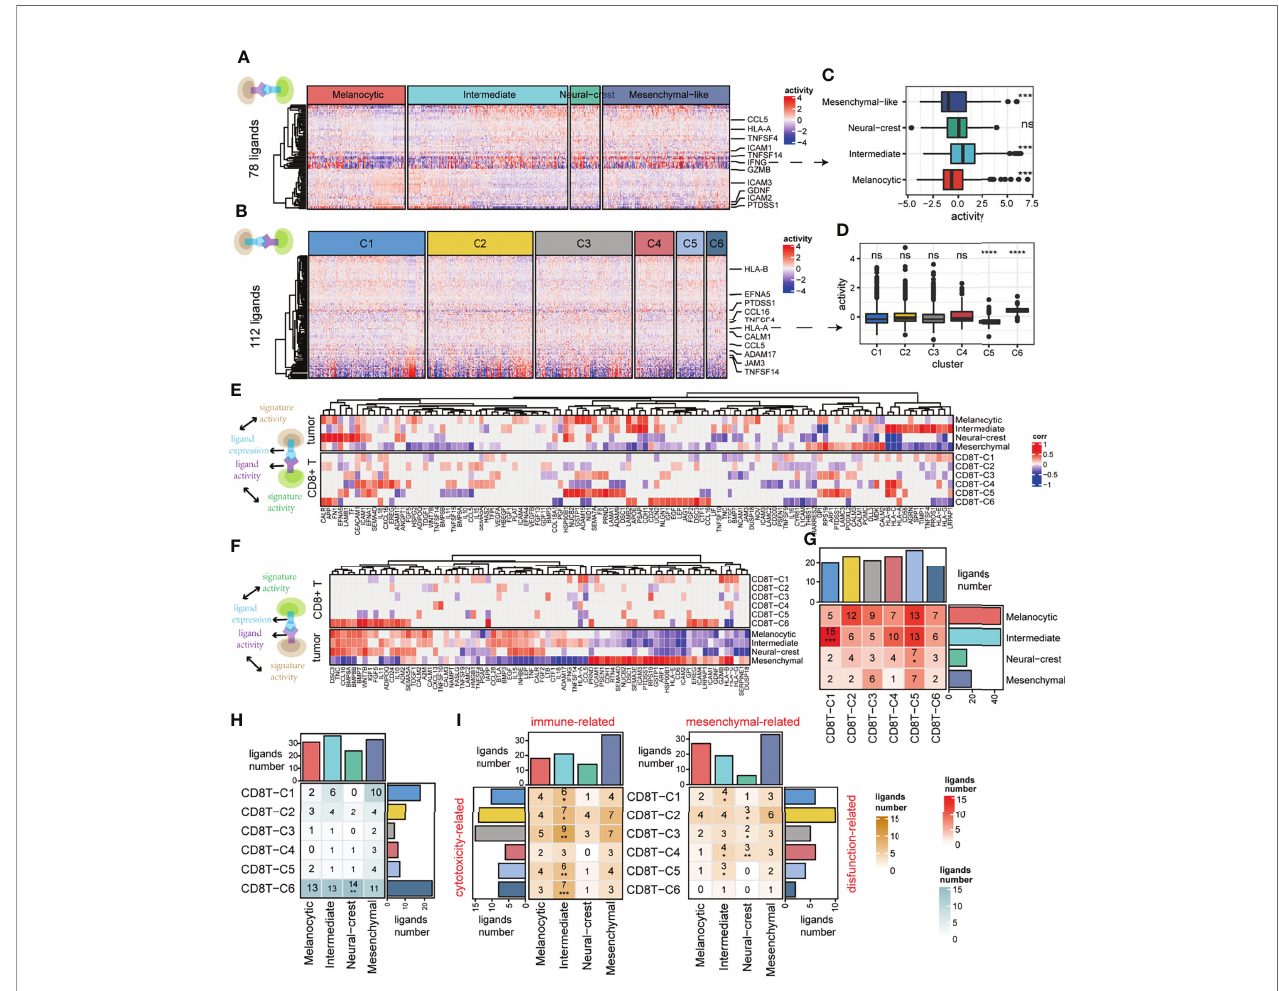
FIGURE 4 | Deciphering the association between cell – cell communication and cell state. (A) Among ligands expressed by CD8+ T cells ( n = 78), predicted ligand activity in receiver tumor cells by the NicheNet method. (B) Among ligands expressed by tumor cells ( n = 112), predicted ligand activity in receiver CD8+ T cells by the NicheNet method. (C) The difference in predicted ligand IFNG activities between tumor cell states. (D) The difference in predicted HLA-A activities between CD8+ T clusters. (E) The top panel of the correlation heatmap shows the ligands associated with the tumor cell states, and the bottom panel shows the ligands associated with the CD8+ T-cell states when CD8+ T cells act as signal receivers. (F) The top panel of the correlation heatmap shows the ligands associated with the CD8+ T- cell states, and the bottom panel shows the ligands associated with the tumor cell state when the tumor cells act as signal receivers. (G, H) The intersection of cell state-related ligands between tumor cells and CD8+ T cells when CD8+ T cells act as signal receivers is shown in (G) , as well as when tumor cells act as signal receivers shown in (H) . (I) The intersection of function-related ligands between tumor and CD8+ T cells when tumor cells act as signal receivers. ns, non-signi fi cant, * denoted p <0.05, ** denoted p <0.01, *** denoted p <0.001, and **** denoted p